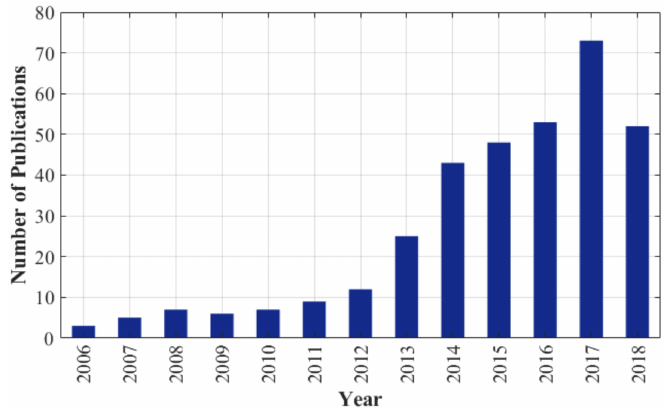
Figure 1. Number of publications on SOC estimation of Li-ion batteries per